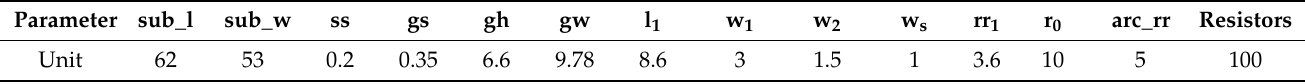
Table 1. Optimal dimensions (mm) and loaded resistors ( Ω ) of modified coplanar tapered slot antenna (TSA). Parameter